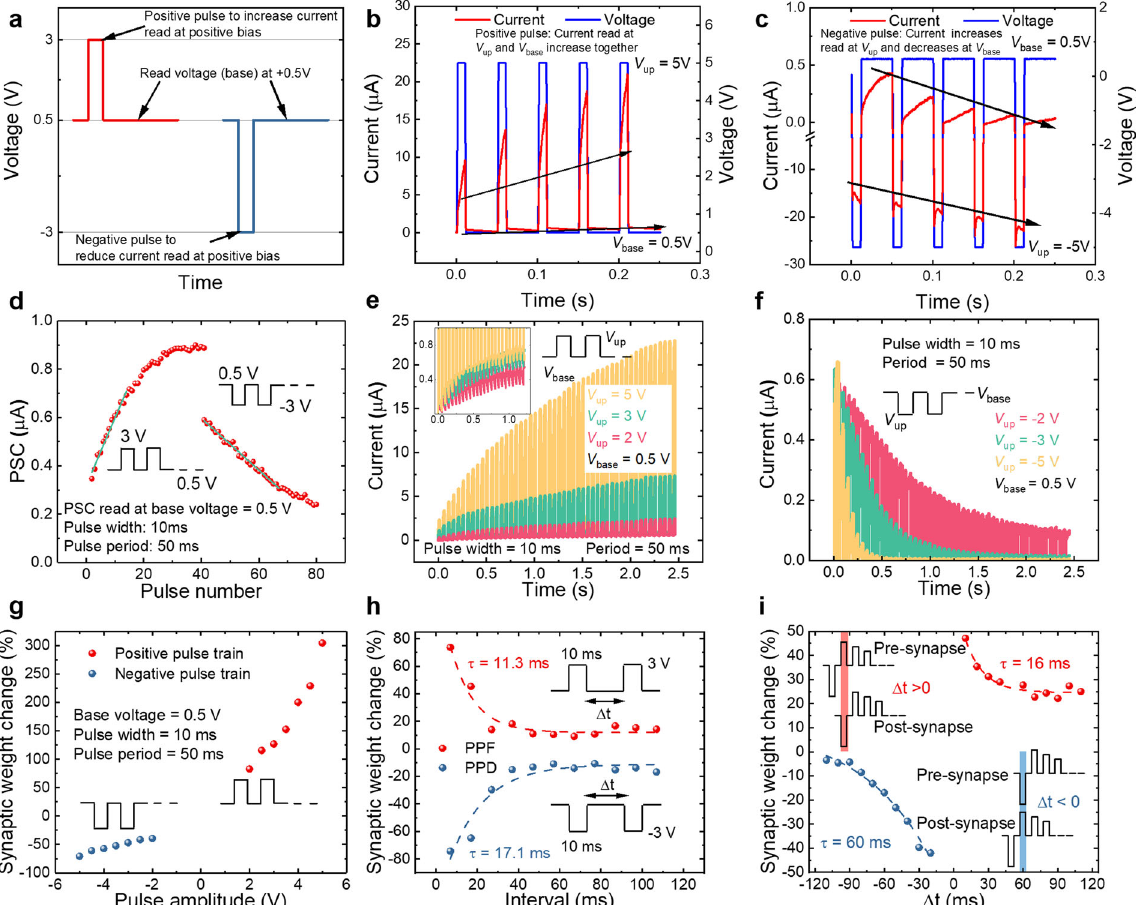
Fig. 6 Pulse measurement for biological synapse emulation. a Schematic of pulse waveform to modulate the synaptic weight. The synaptic weight refers to the current as read at + 0.5 V base voltage. b Potentiation measurement. Current read at + 5 V and + 0.5 V increases together. c Depression measurement. Current read at − 5 V increases, but current read at + 0.5 V decreases. d LTP and LTD measured by successive positive and negative pulses. The green lines show the linear fi tting. PSC are measured at 0.5 V base voltage. e Dynamic response of potentiation at pulse trains with amplitude of 2 V, 3 V, and 5 V. Inset shows the base current read at 0.5 V. f Dynamic response of depression at pulse trains with amplitude of − 2 V, − 3 V, and − 5 V. The currents shown in the fi gure were read at a base voltage of 0.5 V. g SADP characteristic. Ten successive pulses were supplied to the device. Current before and after the pulse train were extracted to calculate the synaptic weight change. All parameters except amplitude were kept the same. h PPF and PPD measurements. Only two pulses were introduced to the device. The dashed lines are exponential fi tting of the data. i STDP measurement. The dashed lines are exponential fi tting. The insets show the schematic illustration of the equivalent pulse waveform